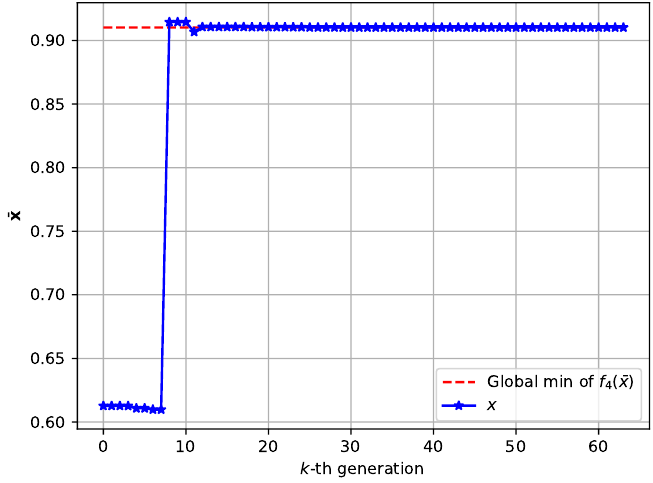
Figure 19. Convergence of the dimension x of f 4 ( ¯x ) in master